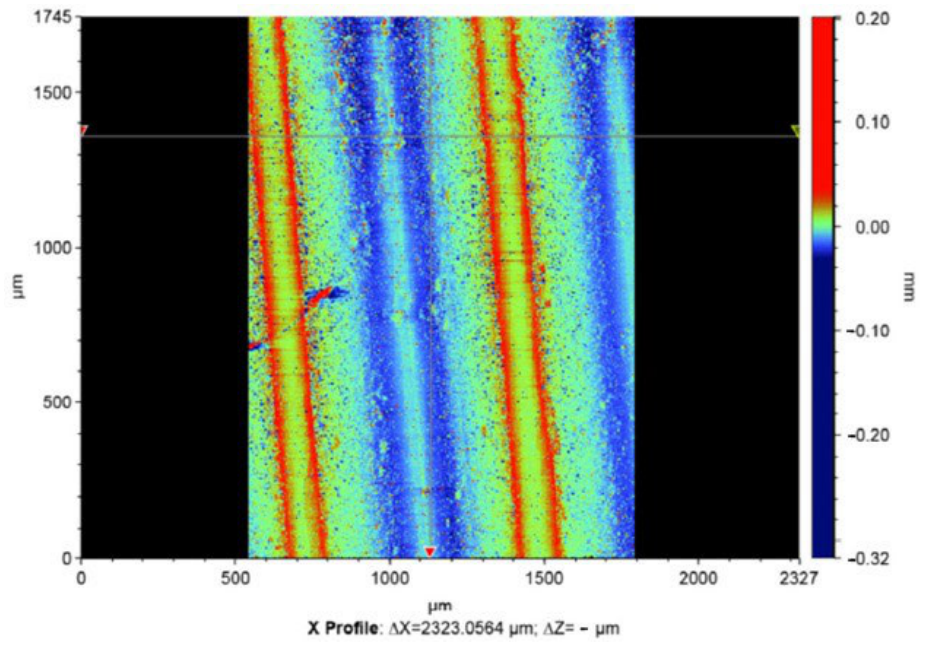
Figure 7. Thread surface quality before thermal pulse processing.